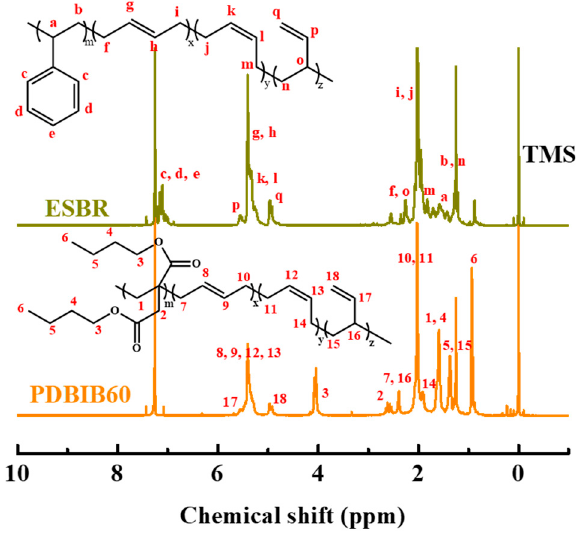
Figure 2. 1 H NMR spectra of PDBIB60 and ESBR.